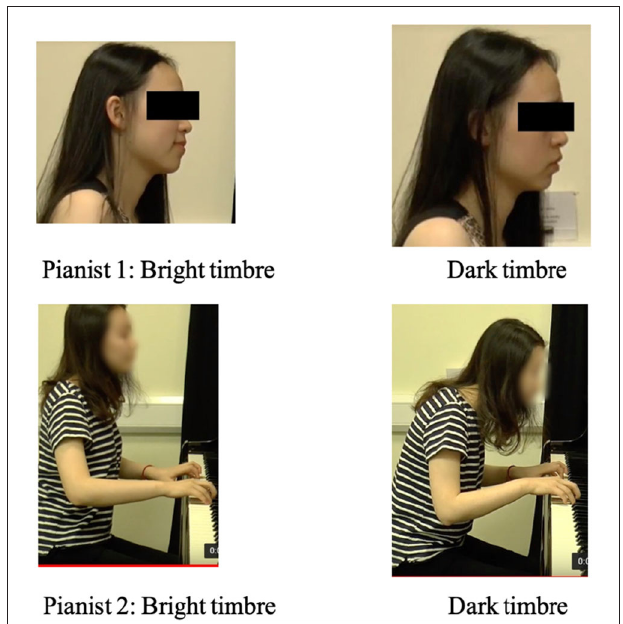
FIGURE 9 | The facial expression and posture of two performers when expressing bright and dark